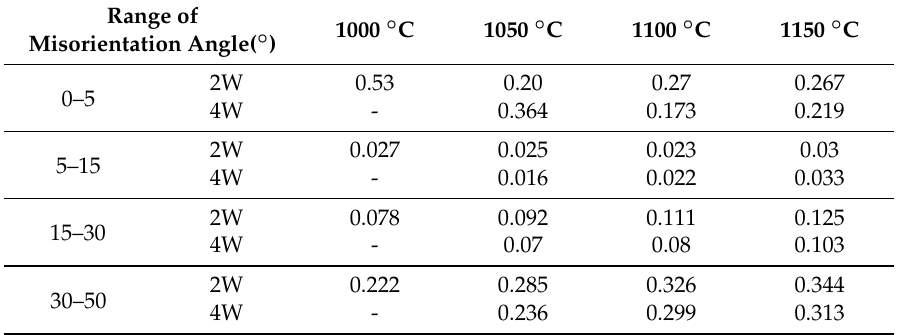
Table 2. The frequency of misorentation angle at different deformed temperature for 2W and 4W. Range of Misorientation Angle( º )